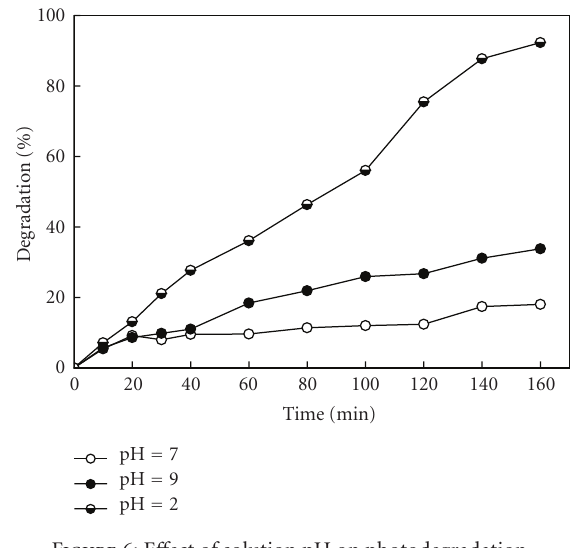
Figure 6: E ff ect of solution pH on photodegradation.